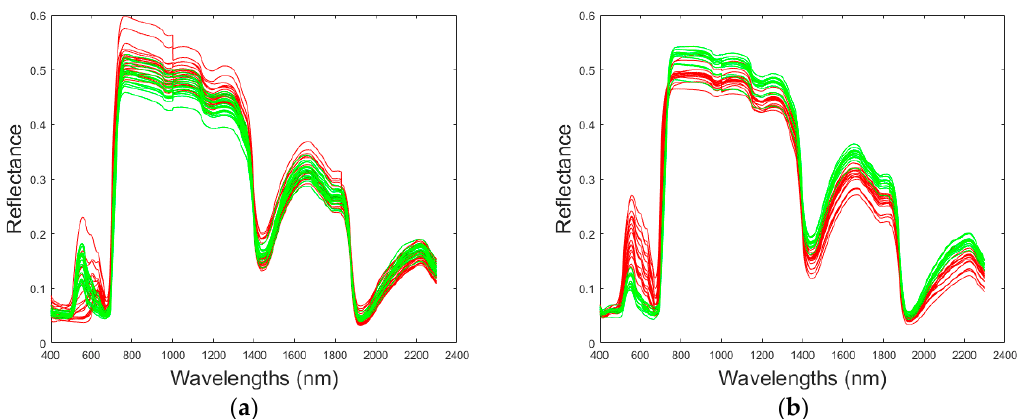
Figure 9. Reflectance of infected (Red) and healthy (green) leaves for Marselan ( a ) and Chardonnay grapevines ( b ).